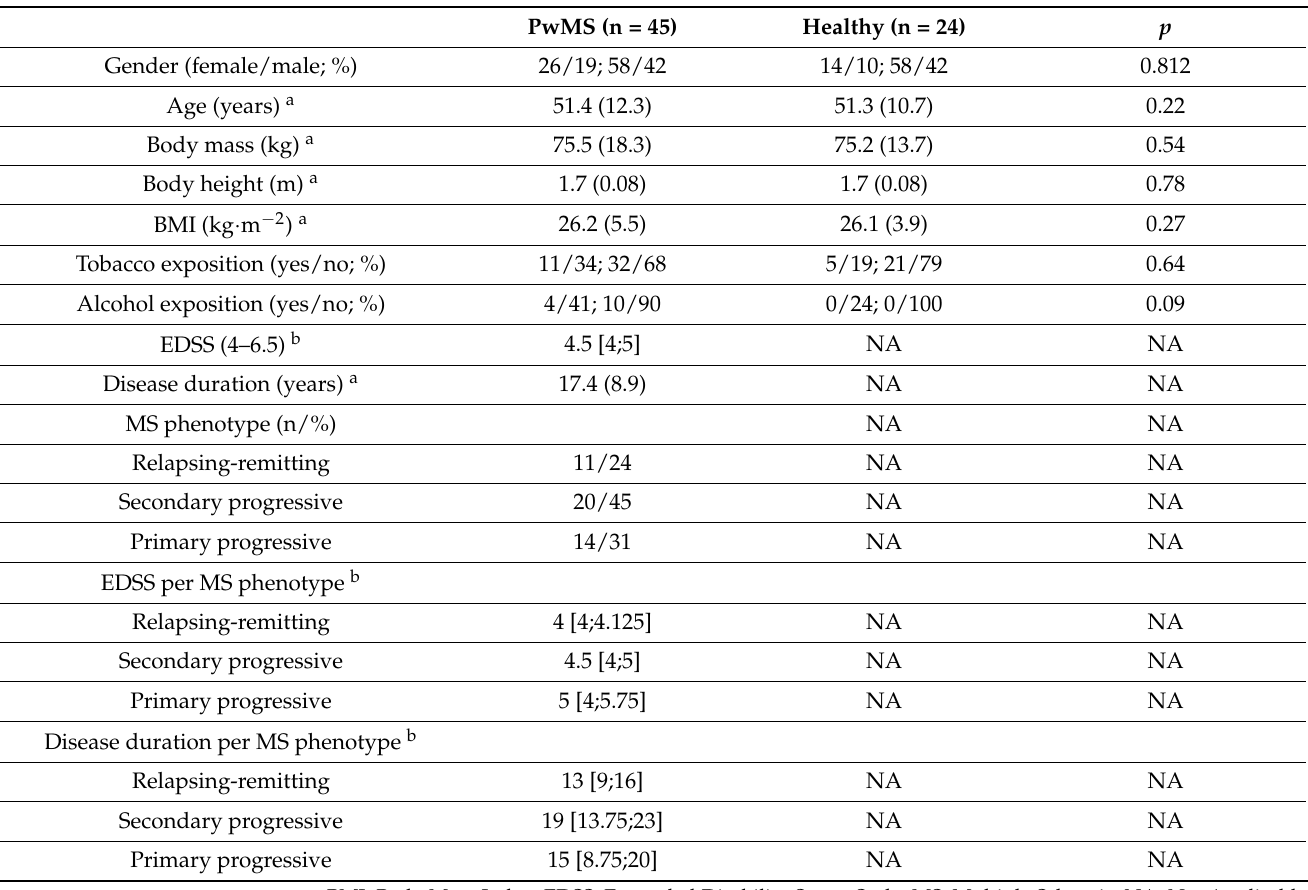
Table 1. Characteristics of the study